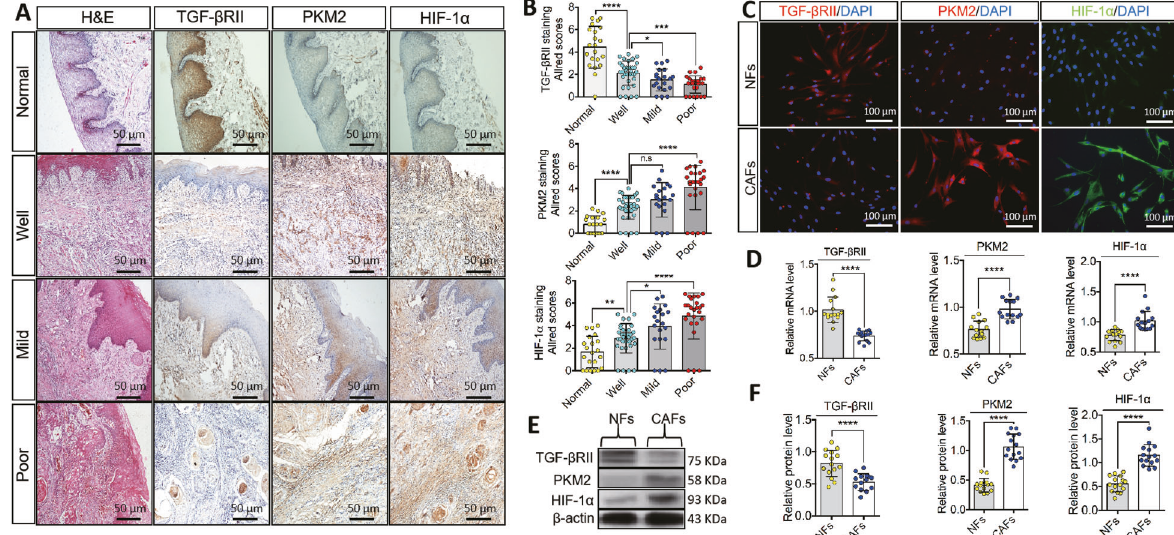
Fig. 1 Expressions of TGF- β RII, PKM2, and HIF-1 α in human oral tissues, normal fi broblasts (NFs), and oral cancer-associated fi broblasts (CAFs). A , B Positive expression of TGF- β RII, mainly located in the cellular membrane and cytoplasm, was detected in the normal tissue and it attenuated gradually in well, mildly and poorly differentiated oral squamous cell carcinomas (OSCCs) with a signi fi cant statistical difference among groups. Conversely, PKM2 and HIF-1 α were weakly positive in the cytoplasm and/or nucleus in the normal tissue and exhibited with augmented positive staining and area in OSCCs. Scale bar = 50 μ m. C Representative fl uorescence images of immunostaining for TGF- β RII, PKM2, and HIF-1 α were detected in NFs and CAFs with DAPI positive nuclei. Scale bar = 100 μ m. D Quanti fi cation of TGF- β RII, PKM2, and HIF- 1 α mRNA levels in NFs and CAFs exhibited a signi fi cant statistical difference. E Immunoblot showed a reduction of TGF- β RII in CAFs but PKM2 and HIF-1 α increased in CAFs when compared to NFs. F Quanti fi cation of TGF- β RII, PKM2, and HIF-1 α protein levels in NFs and CAFs with a signi fi cant statistical difference. Relative mRNA or protein expression level was quanti fi ed after normalization to β -actin. n ≥ 15; error bars, mean ± SD; n.s not signi fi cant, * P < 0.05, ** P < 0.01, *** P < 0.001, **** P < 0.0001; t test.